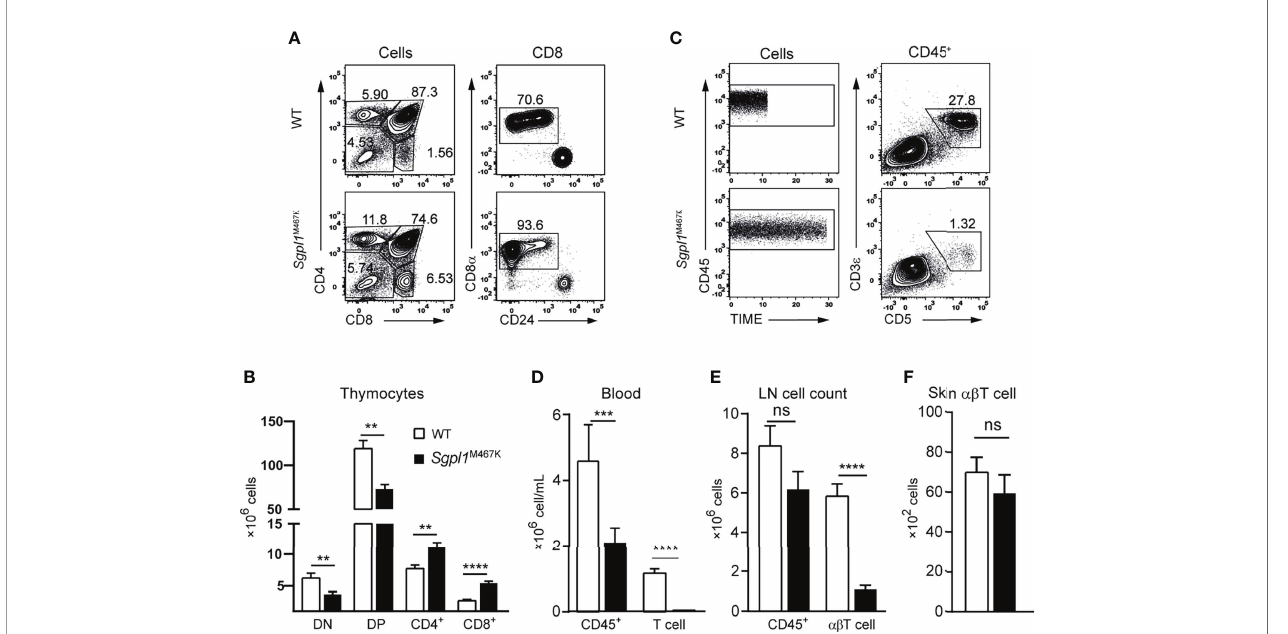
FIGURE 3 | Sgpl1 M467K mutation impaired ab T cell development and cell count in blood and LN. (A, B) Thymocytes were analyzed with a fl ow cytometer. (A) Representative fl ow cytometer fi gure; the DN, DP, CD4 subsets were de fi ned from all cells; the CD8 + was further de fi ned from CD8 single-positive cells by removing the ISP population. (B) Absolute number of different thymocytes subsets within a thymus. Data were pooled from sixteen mice from four different experiments. (C, D) Periphery blood lymphocytes and T cell count were accessed with Attune Flow cytometry. (C) Representative fl ow cytometer fi gure; the same amount of CD45 + cells were acquired using the same fl ow speed, the different length of time under the same arbitrary unit re fl ects the CD45 + cell concentration. (D) Blood cell concentration. Experiments repeated more than 10 times, data was from fourteen mice of one representative experiment. (E) Absolute cell counts of LN CD45 + and abT cells. Data pooled from eighteen mice from three independent experiments. (F) Skin ab T count under steady-state. Data pooled from two experiments of thirteen mice. ****, p<0.0001; ***, p<0.001; **, p<0,01; ns, not signi fi cant; analyzed with unpaired t-test, error bar represents